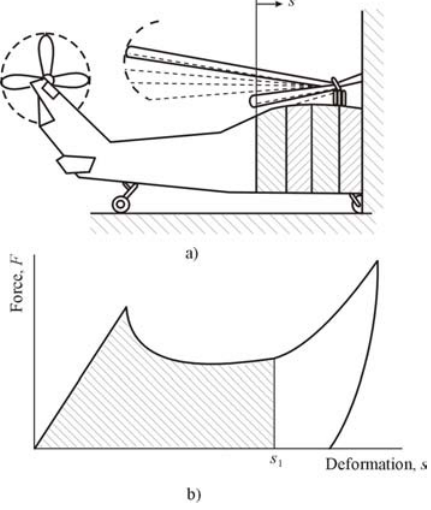
Fig 1 . Kinetic energy descending during impact